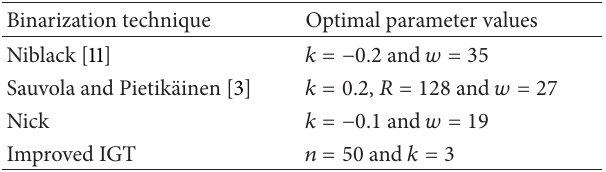
Table 1: Optimal parameters values of the parameterized